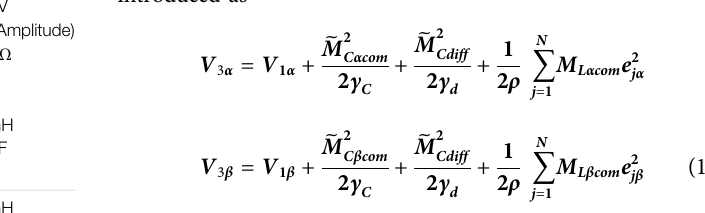
TABLE 1 | System parameters in the simulation. Item Speci fi cations The fi lter parameters are balanced Output inductors ( L 1 a ∼ L 4 a , L 1 b ∼ L 4 b , L 1 c ∼ L 4 c )